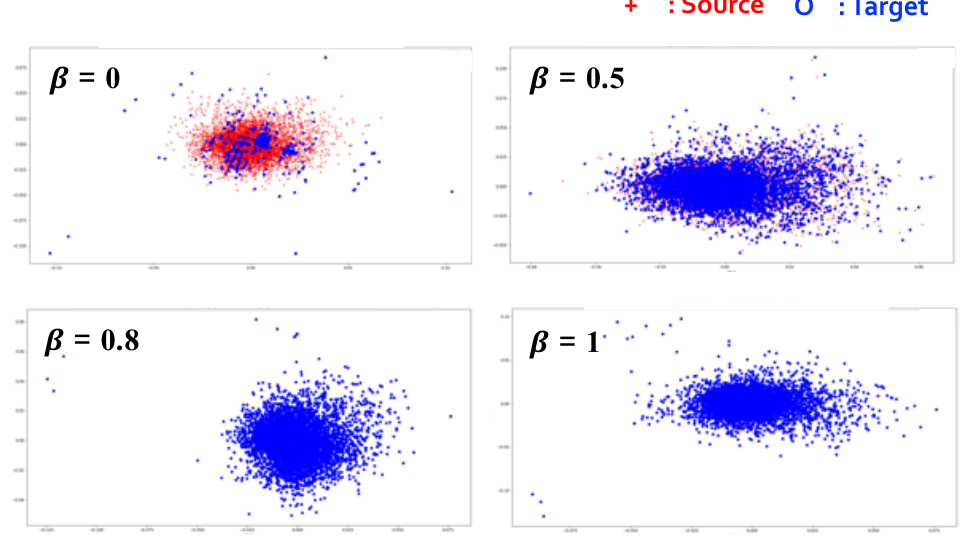
Figure 6. Distribution diagram according to similarity parameter β (class: LDAP injection, source domain: PKDD2007, target domain: